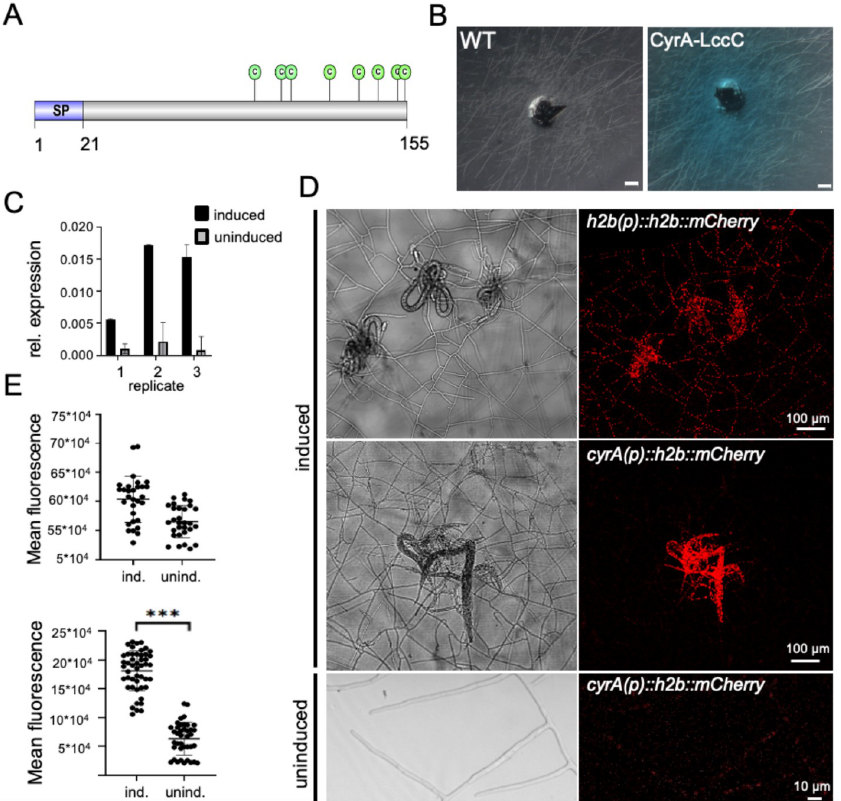
Fig 1. CyrA is a secreted cysteine-rich protein induced during trap formation. (A) Scheme of CyrA. The 155 amino acid long protein contains a 21 amino acid long signal peptide and a cysteine-rich region with eight cysteine residues. (B) The CyrA-LccC expressing D . flagrans strain sNH08 and the WT were grown on LNA with 1 mM ABTS for 48 hours. (C) Quantitative real time PCR analysis of cyrA expression in D . flagrans hyphae grown on LNA and in hyphae and traps co-cultivated for 24 h with C . elegans . The three biological replicates are displayed individually, and the error bar indicates the standard deviation of three technical replicates, P-value = 0.0342. The expression was normalized to actin. (D) Spatial analysis of cyrA expression using a transcriptional reporter assay. The h2b-mCherry reporter was expressed under the constitutive h2b (sNH14) or the cyrA promoter (sNH21), respectively. Pictures of traps and captured nematodes were taken after 24 h of co-incubation. Scale bar = 100 μ m. Pictures of uninduced mycelium were taken after 24 h at 28˚C. Scale bar = 10 μ m. (E) The mean fluorescence of single nuclei of the reporter strains in traps (ind.) and vegetative mycelium (unind.) was measured in different pictures taken with the same settings using ImageJ (arbitrary units). cyrA(p) uninduced n = 39, cyrA(p) induced n = 48, h2b(p) uninduced n = 30, h2b(p) induced n = 30. P-value h2b(p) induced vs. cyrA(p) induced <